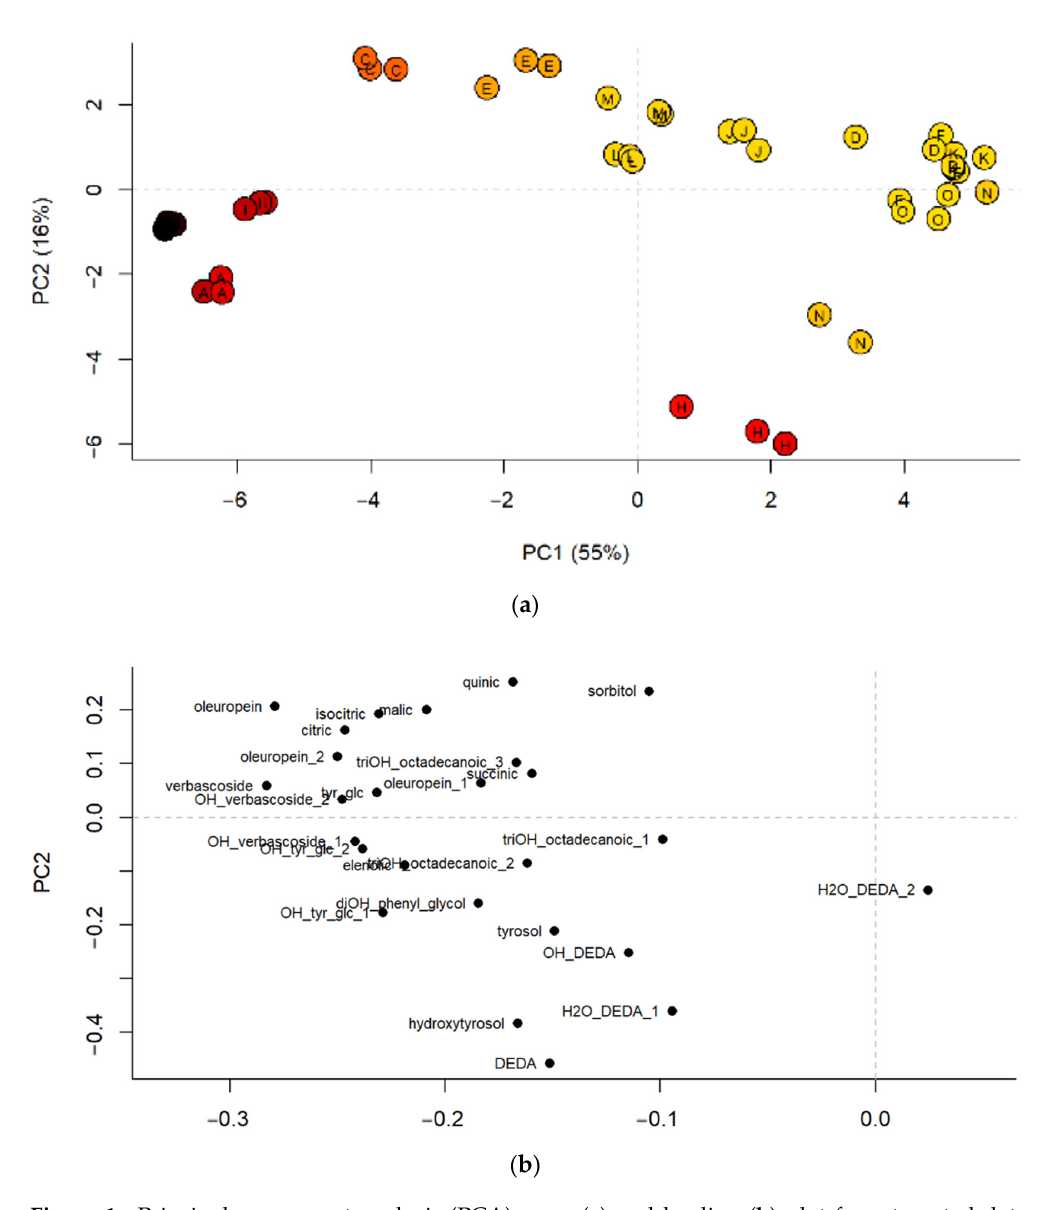
Figure 1. Principal component analysis (PCA) score ( a ) and loading ( b ) plot from targeted data. Samples in the score plot ( a ) are colored according to the total amount of quantified compounds, with a scale from black to yellow through red, in descending order.